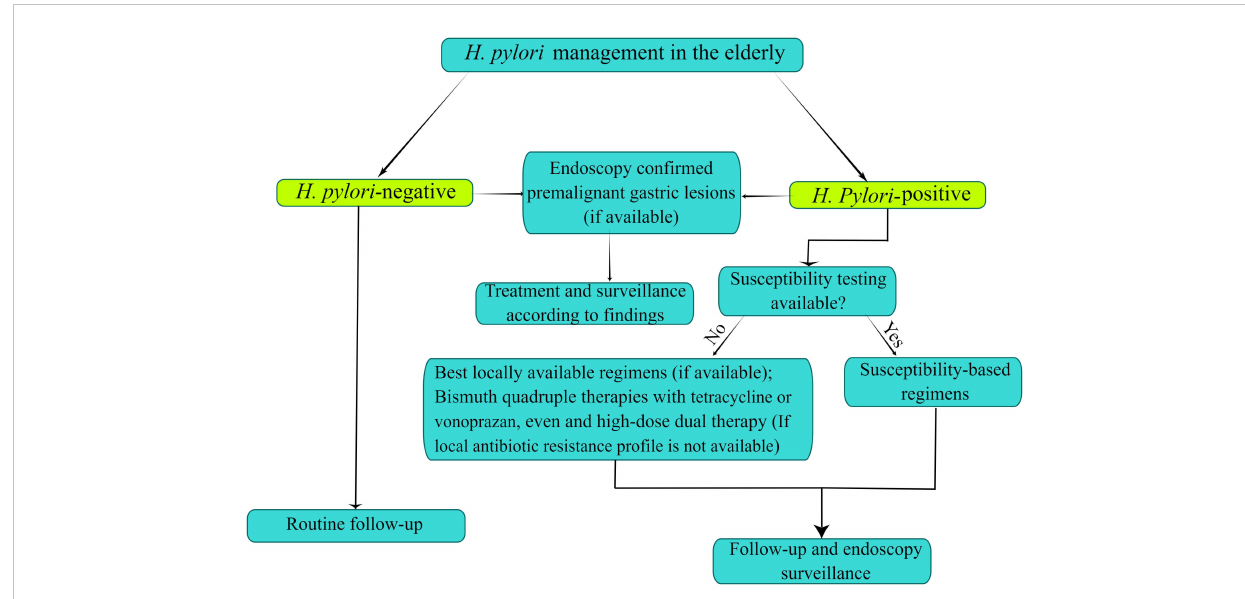
FIGURE 2 Flowchart of Helicobacter pylori infection control and management in the elderly. The fi gure is drawn by